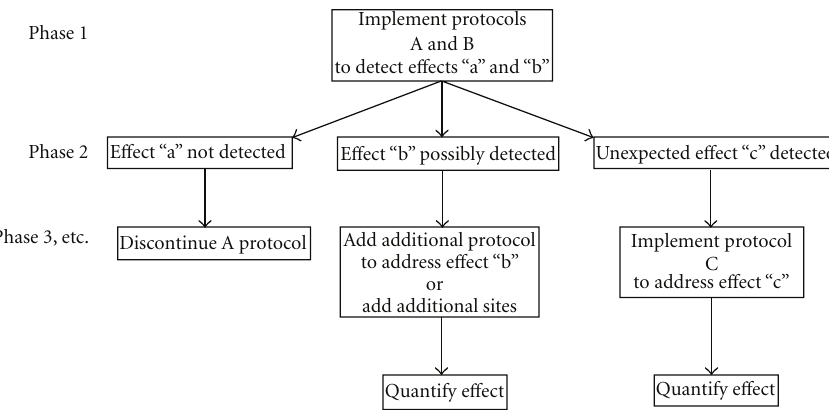
Figure 1: Proposed adaptive and reactive monitoring framework.